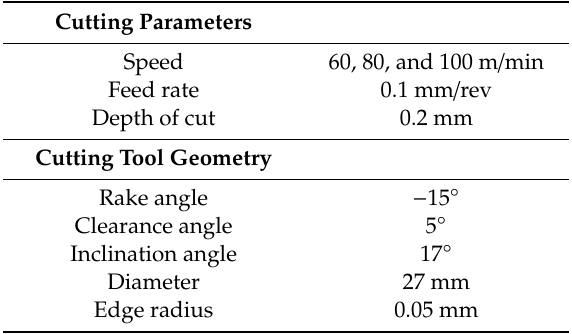
Table 2. Variables of cutting and tool geometry for the finite element